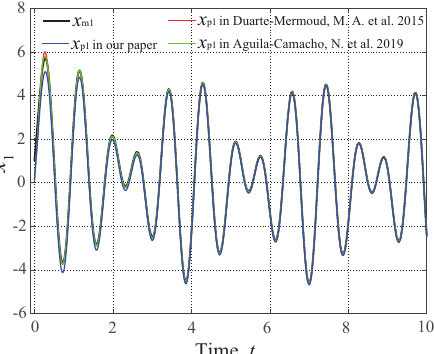
( t ) and x m ( t ) with the standard fractional order 1 1